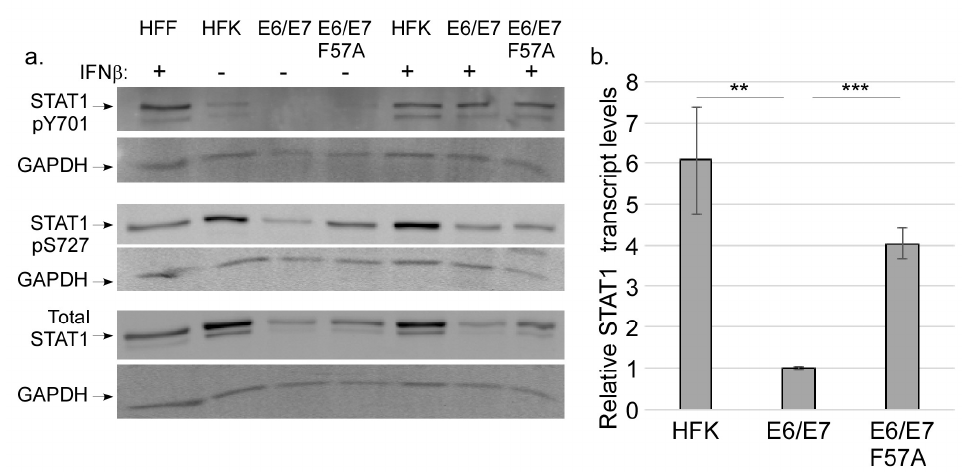
Figure 4. STAT1 levels and modification. ( a ) Western blot analysis of protein levels of pY701 (top panel), pS727 (middle panel), total STAT1 (bottom panel), and GAPDH in HFKs, pLXSN E6 / E7, and pLXSN E6 / E7 F57A cells that were treated with vehicle (IFN β − ) or 50 U / mL IFN β (IFN β + ) for 2 h under monolayer culture conditions. Protein from uninfected human foreskin fibroblasts (HFF) treated with IFN β was a positive control for STAT1 activation. ( b ) RT-qPCR analysis of STAT1 transcripts in untreated HFKs, pLXSN E6 / E7, and pLXSN E6 / E7 F57A cells. Transcripts were normalized to cyclophilin A housekeeping gene with pLXSN E6 / E7 values set to 1.